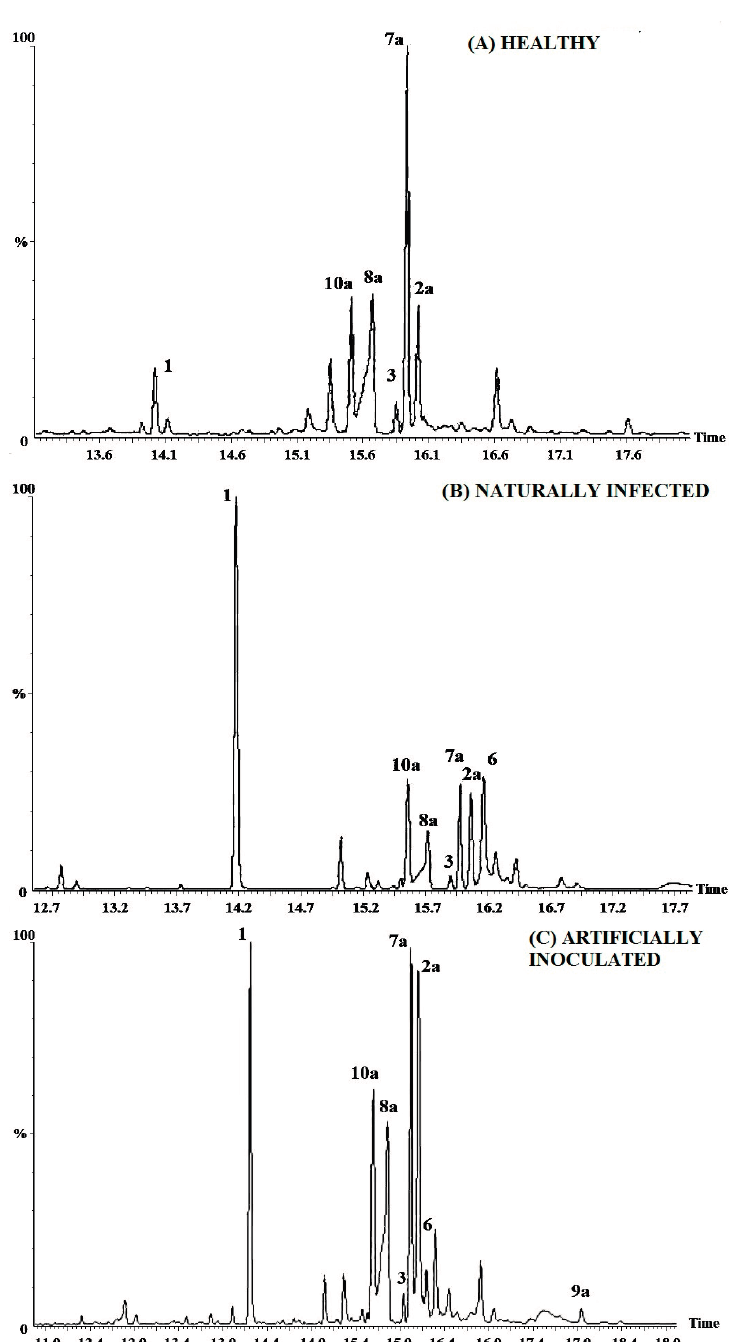
Figure 3. GC profiles of the Austrocedrus chilensis resin constituents from healthy and Phytophthora austrocedri -infected trees. ( A ) Healthy; ( B ) Naturally infected; ( C ) Artificially